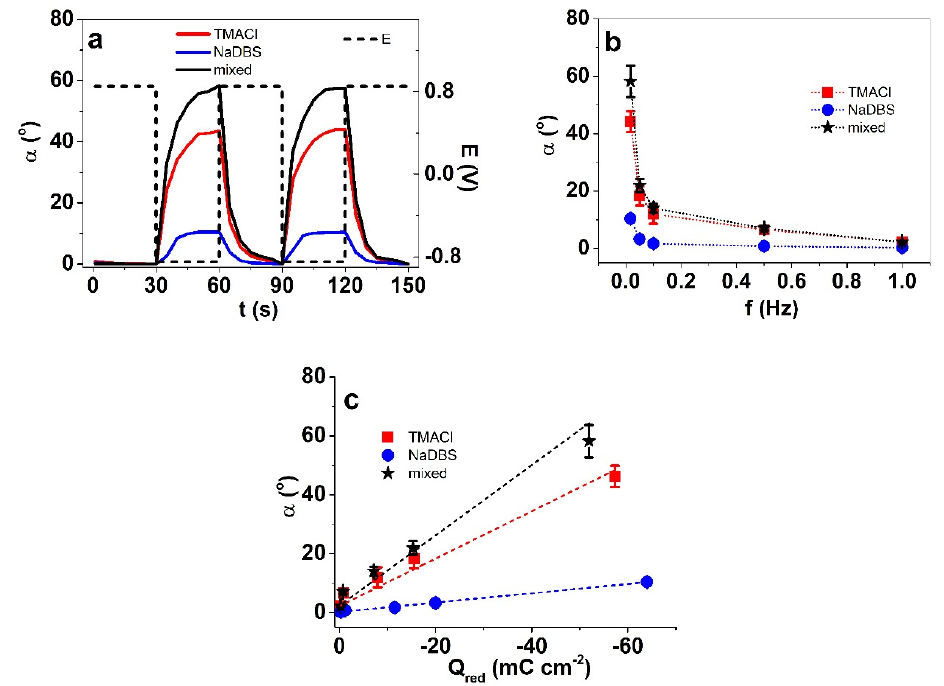
Figure 2. Square wave potential step measurements of PET-PPy bilayer in potential range ± 0.85 V showing in ( a ), the displacement angle α and potential E (dashed) against time t of two subsequent cycles (fourth–fifth) at 0.017 Hz in aqueous electrolytes containing 0.05 M TMACl (red line), 0.05 M NaDBS (blue line), and mixed 0.05 M TMACl + 0.05 M NaDBS (black line). The dependencies of displacement on frequency of the PET-PPy bilayers in TMACl ( ■ ), NaDBS ( ● ), and mixed ( ★ ) are shown in ( b ), and the displacements of the samples against the charge densities upon reduction (Q red )